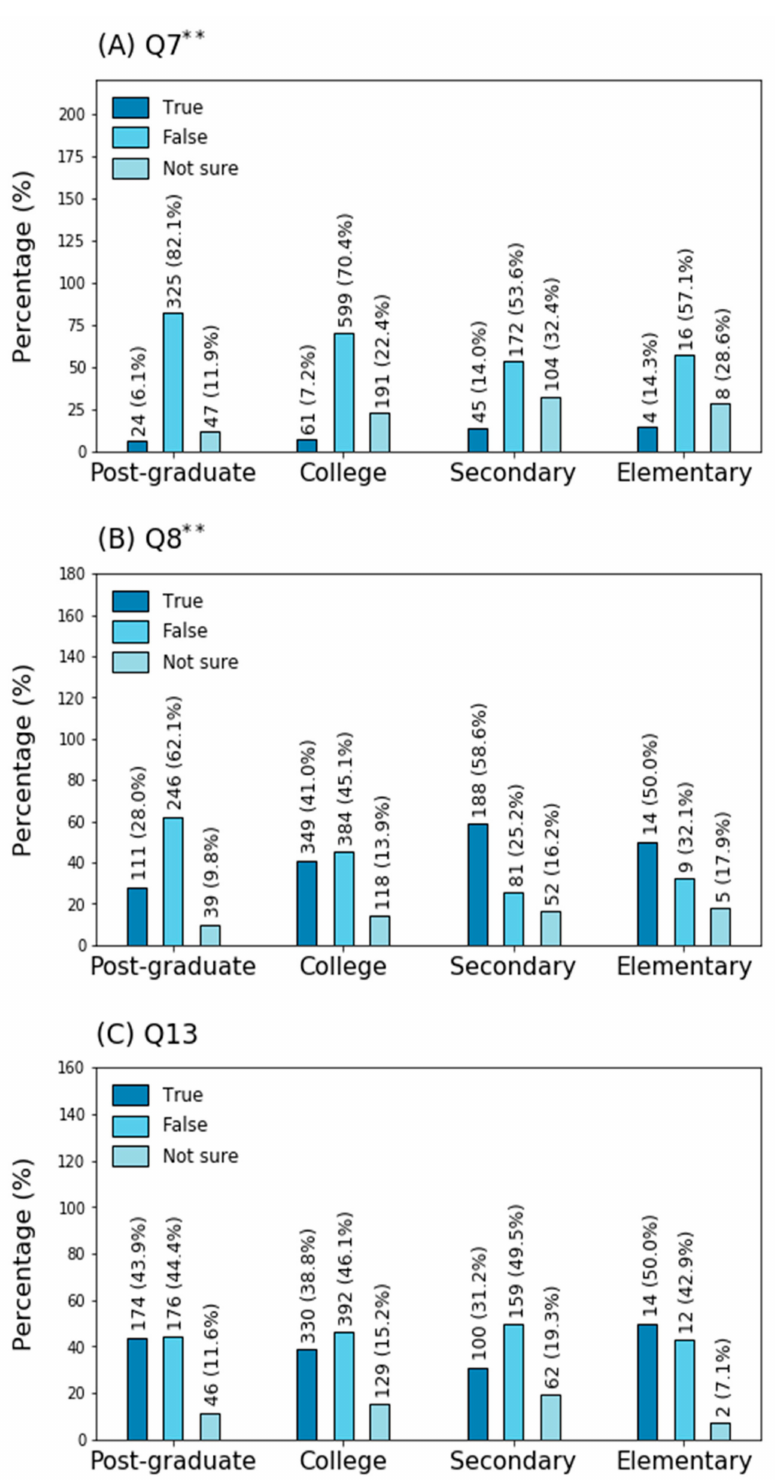
Figure 1. Comparison of response percentages among educational groups: ( A ) Question 7; ( B ) Ques- tion 8; ( C ) Question 13. ** Chi-square values significant at p <